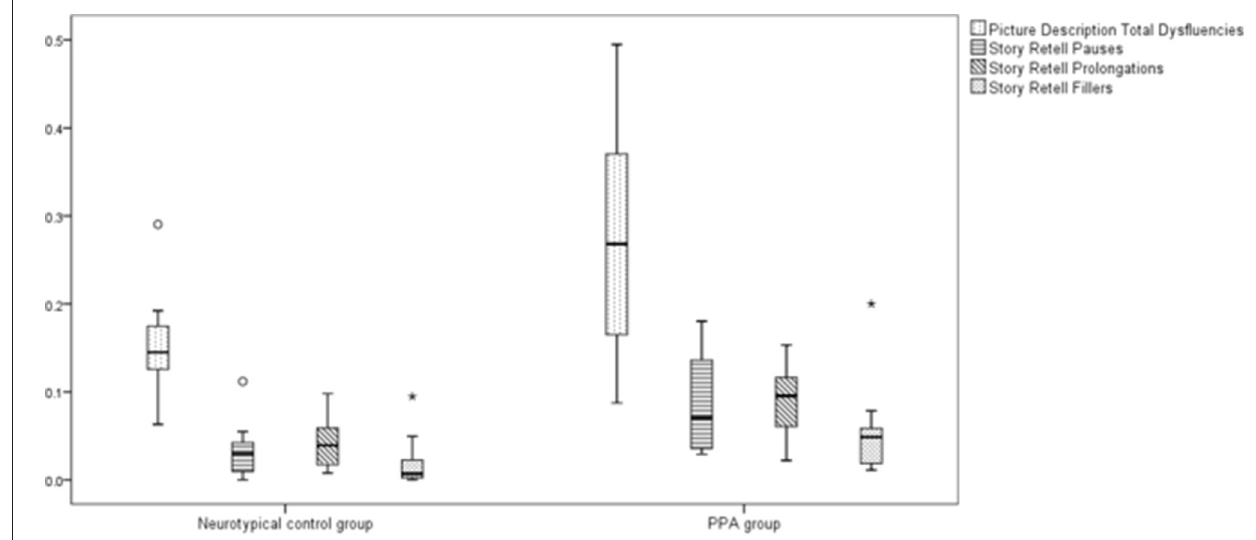
FIGURE 1 | Differences between individuals with PPA and neurotypical adults for fluency measures.